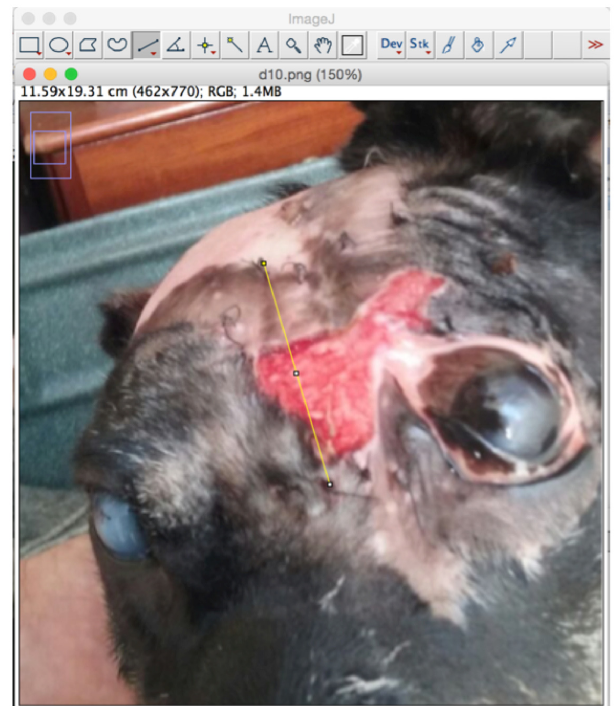
Figure 3. ImageJ software image analysis approach for quantitative size measurements of wounds - Part 1. The first part of the method is to use the Set scale function on the image analyzed for a known distance, visible on the photo. In this case, the distance chosen was the length of the biomembrane (with the sutures used for cue points of approximate termini of the biomembrane, useful for later time points when the original biomembrane had been completely absorbed into the patient tissue), with a correction applied to account for the inclination of the target plane, using a trigonometric